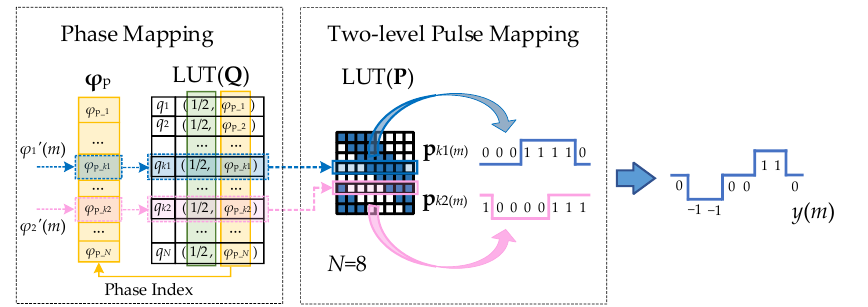
Figure 5. Mapping flowchart of MPWM.